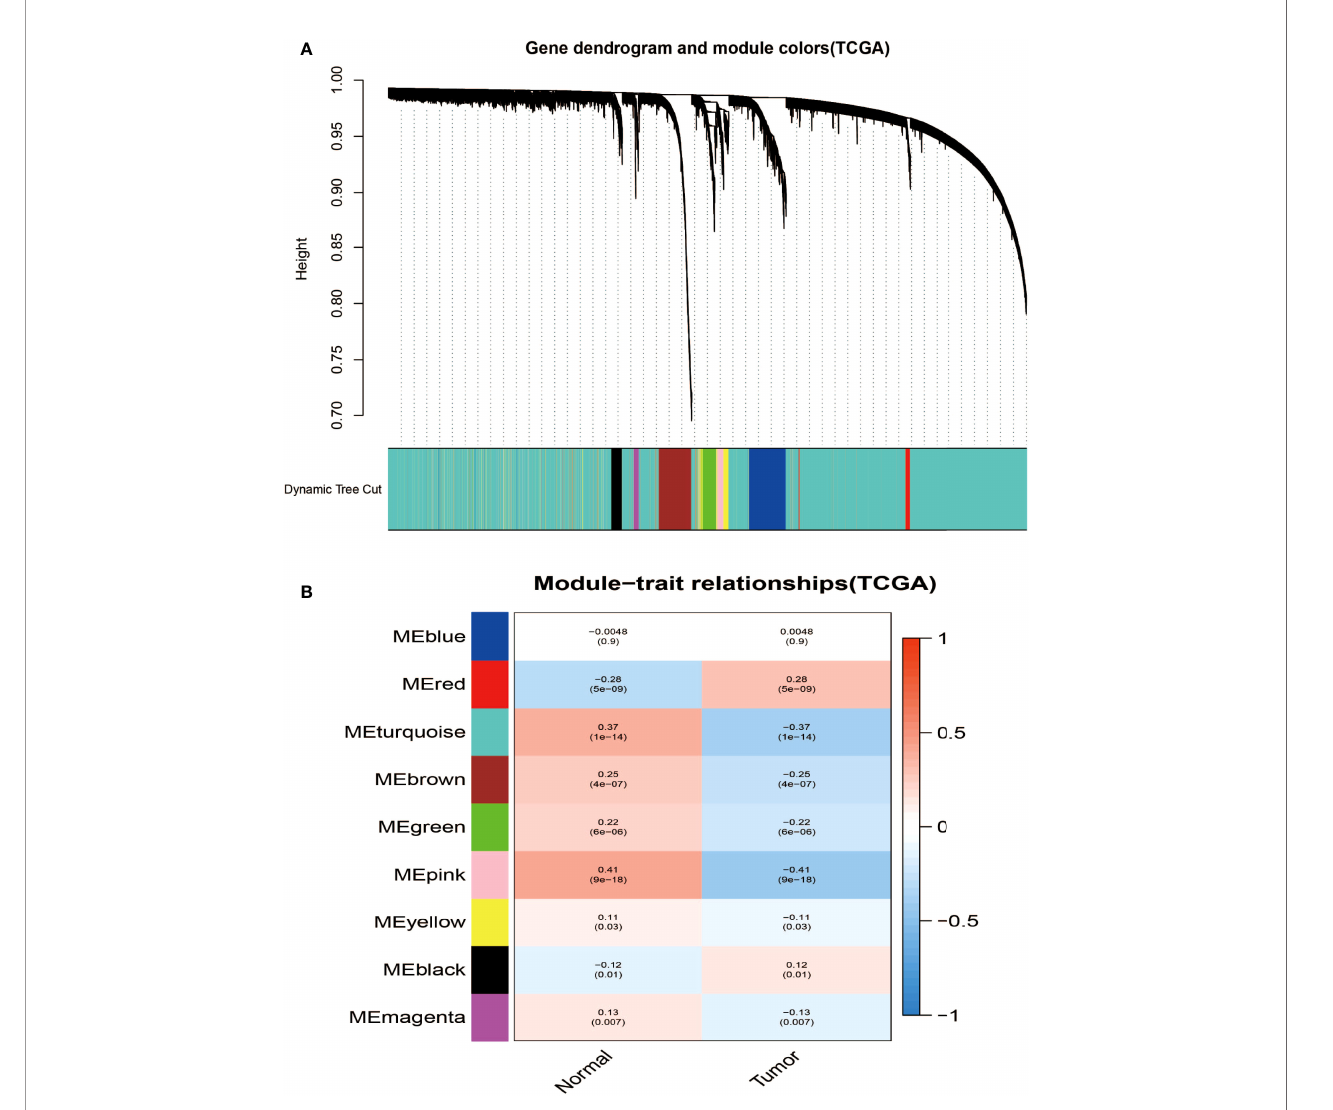
FIGURE 2 | Identi fi cation of modules associated with the clinical information in the TCGA-STAD dataset. (A) The cluster dendrogram of co-expression network modules was ordered by a hierarchical clustering of genes based on the 1-TOM matrix. Each module was assigned different colors. (B) Module – trait relationships. Each row corresponds to a color module and each column corresponds to a clinical trait (cancer and normal). Each cell contains the corresponding correlation and P